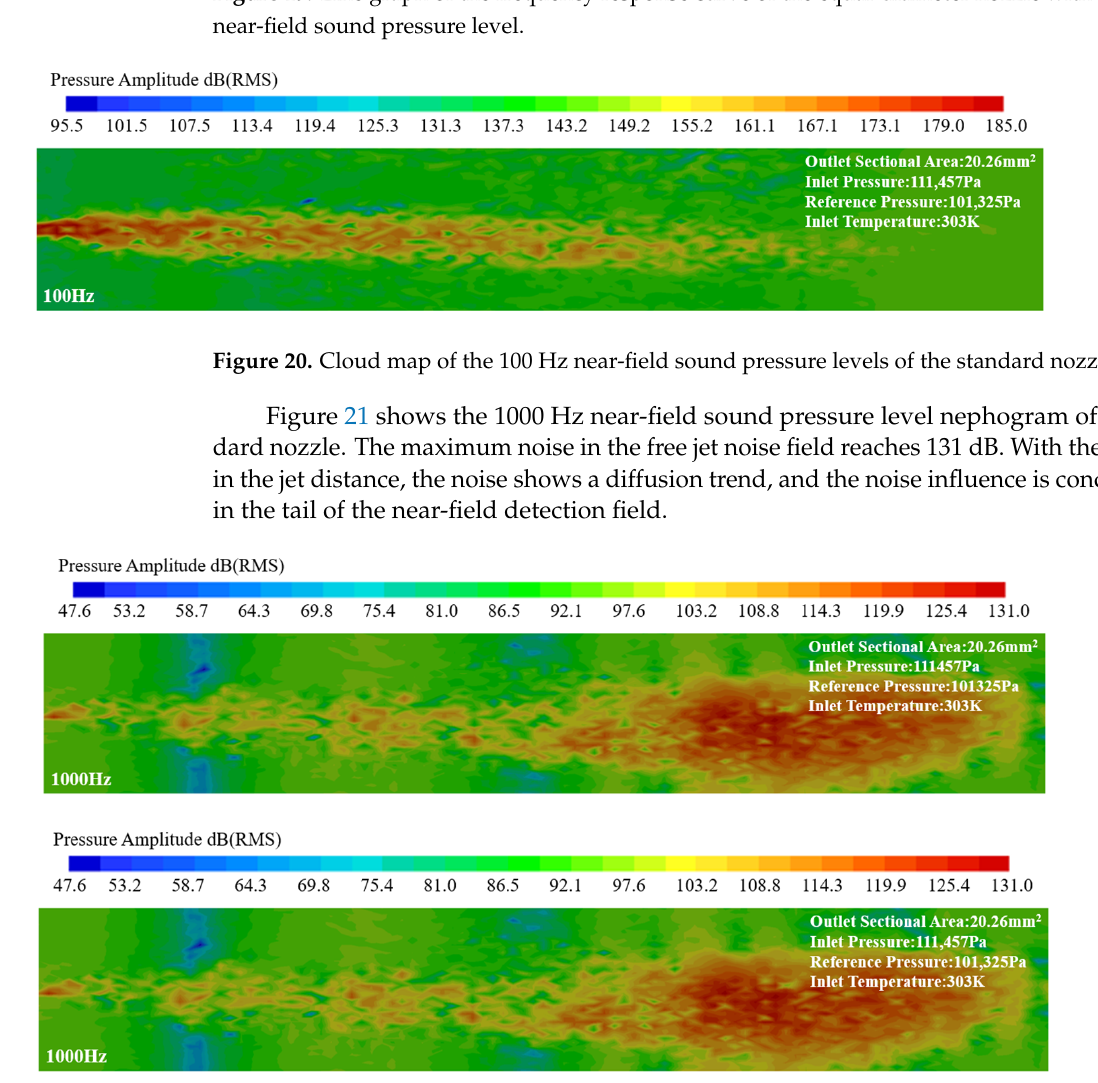
Figure 21. Cloud map of the 1000 Hz near-field sound pressure levels of the standard